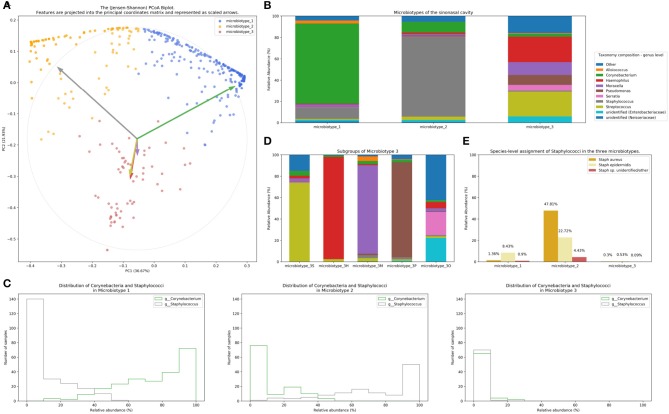
Microbiotyping the sinonasal microbiome. (A) Illustration of the assigned microbiotypes on the Jensen-Shannon PCoA biplot. Arrows were used to depict the projection of the genera onto the PCoA matrix. Each arrow is indicated by the color of the genus according to the Legend. (B) Taxonomic composition of the three microbiotypes at the genus level. (C) Histograms demonstrating the relative abundance of Corynebacterium and Staphylococcus. (D) Subgroups of microbiotype 3 (hierarchical density-based clustering). (E) Distribution of staphylococcal species (mean relative abundance).